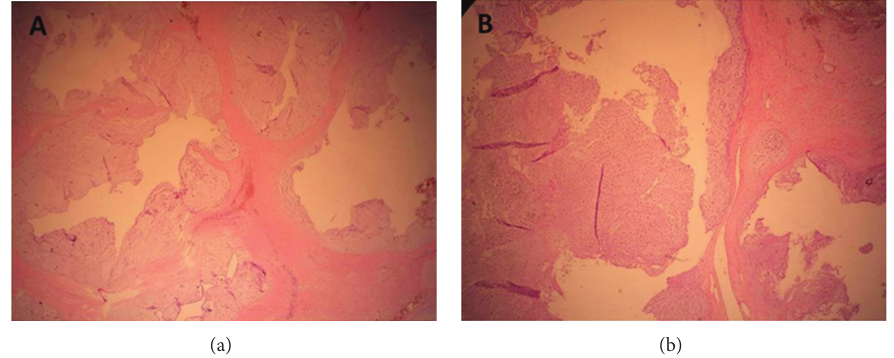
F 3: Photomicrograph of the resected tumor showing (Hematoxylin and Eosin, chondrocyte atypias and neoplastic chondrocytes.